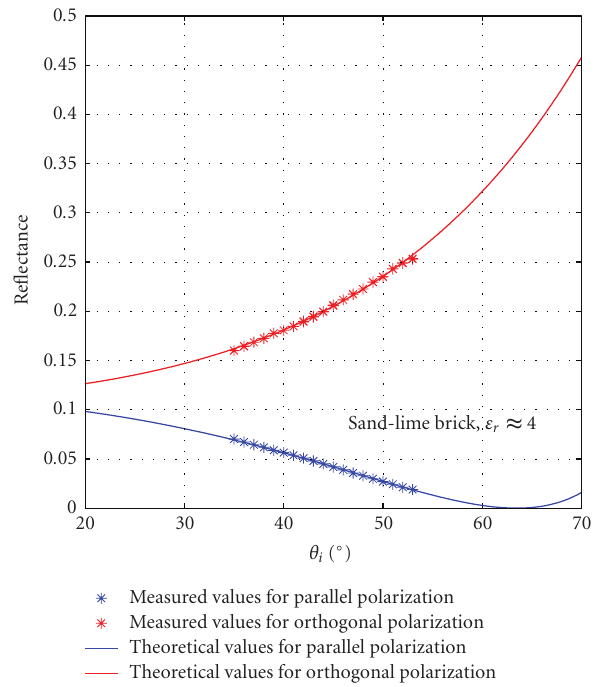
Figure 2: Measured and theoretical reflectance factors of sand-lime